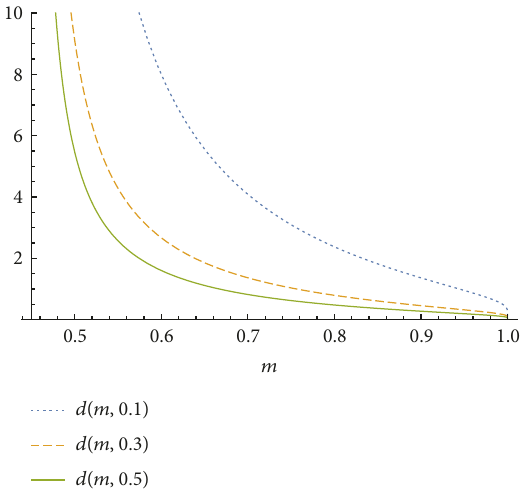
Figure 5: Coefficient 𝐷(𝑚, 𝛼) (41) of solution (4) as function of 𝑚 for 𝛼 = 0.1, 0.3, 0.5 .